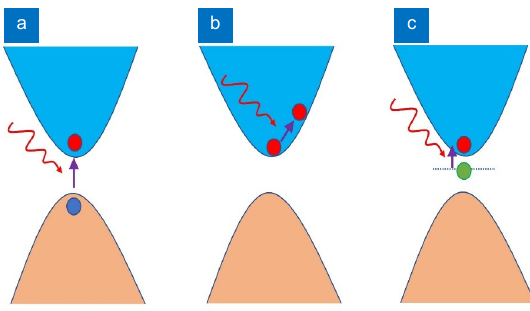
Fig. 2 | Basic optical detection mechanism in semiconductors . ( a ) Intrinsic absorption (interband transition), ( b ) Free carrier absorp- tion, ( c ) Extrinsic absorption (impurity